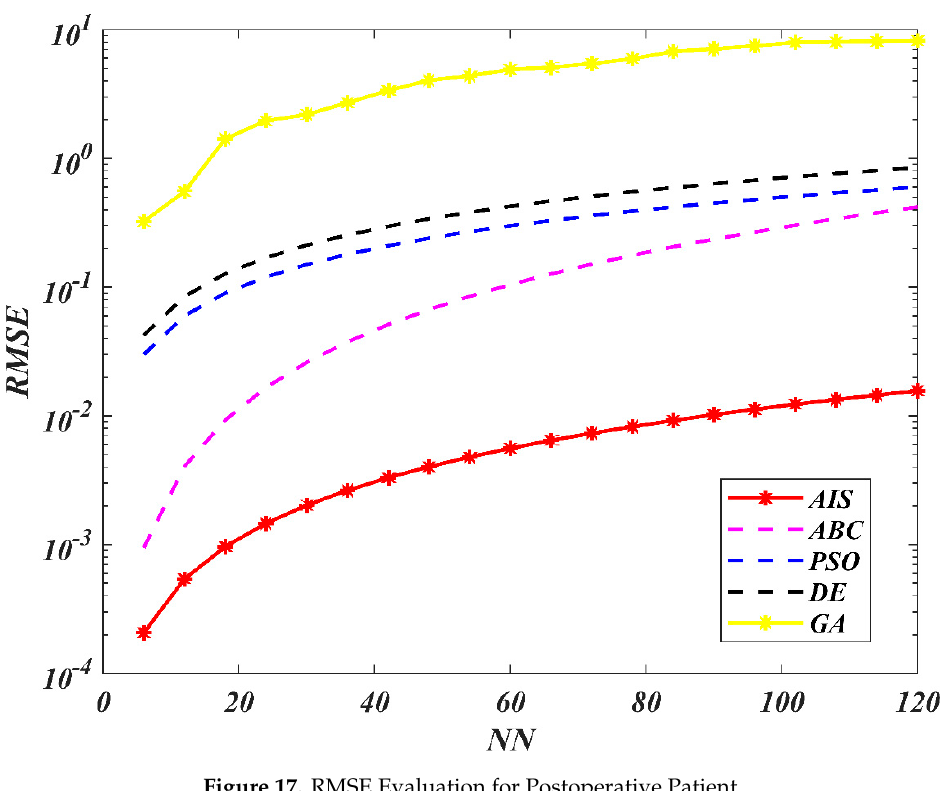
Figure 17. RMSE Evaluation for Postoperative Patient.